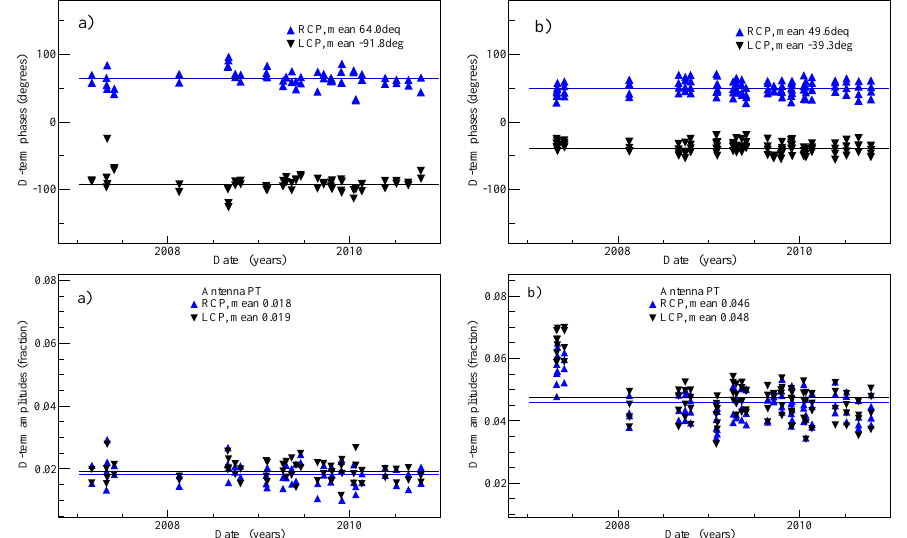
Figure 1. ( a ) D-term right-left circular polarization (RCP) (blue triangles) and LCP (black inverted triangles) phases ( up ) and amplitudes ( bottom ) for PT antenna at 4.6 GHz, two IFs. Solutions for phases are adjusted to lie in a range ± 180 ◦ . The mean values are given. ( b ) The same as in ( a ), but for 15.4